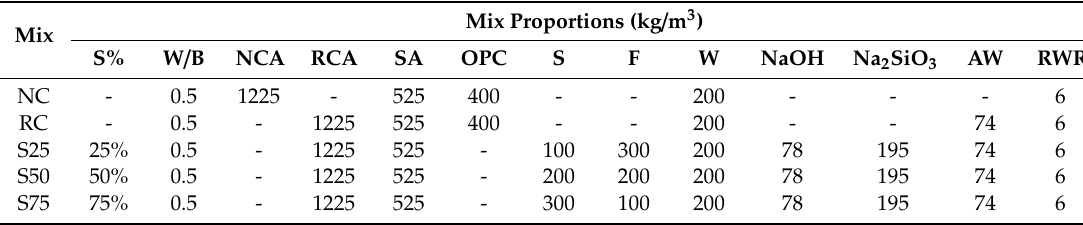
Table 7. Mix proportions. (Reproduced from the previous work [46] with permission from Elsevier).